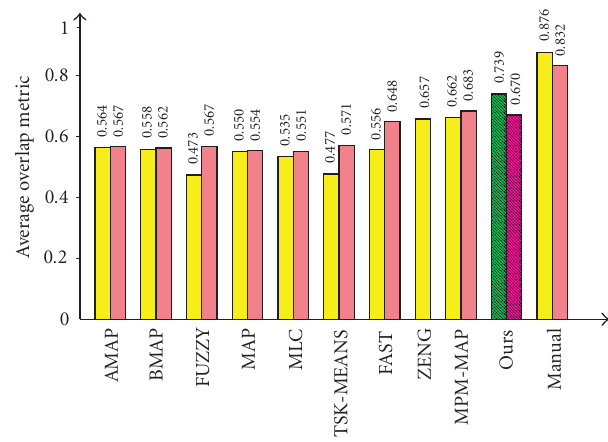
Figure 12: Average overlap metric for GM and WM segmentations on 20 normal real brains for various segmentation methods. The results of some automatic segmentation methods were provided by IBSR or related papers. For each method, the left column rep- resents the average overlap metric of GM segmentation, the right column represents the average overlap metric of WM segmenta- tion. For our method, the left column represents the average overlap metric of GM segmentation, the right column represents the aver- age overlap metric of WM segmentation. AMAP: adaptive MAP; BMAP: biased MAP; FUZZY: fuzzy C -means; MAP: maximum a posteriori probability; MLC: maximum likelihood; TSK-MEANS: tree-structure k -means; FAST: hidden Markov method [28]; ZENG: coupled-surface method [14]; MPM-MAP: Bayesian method [27]; DFM: our